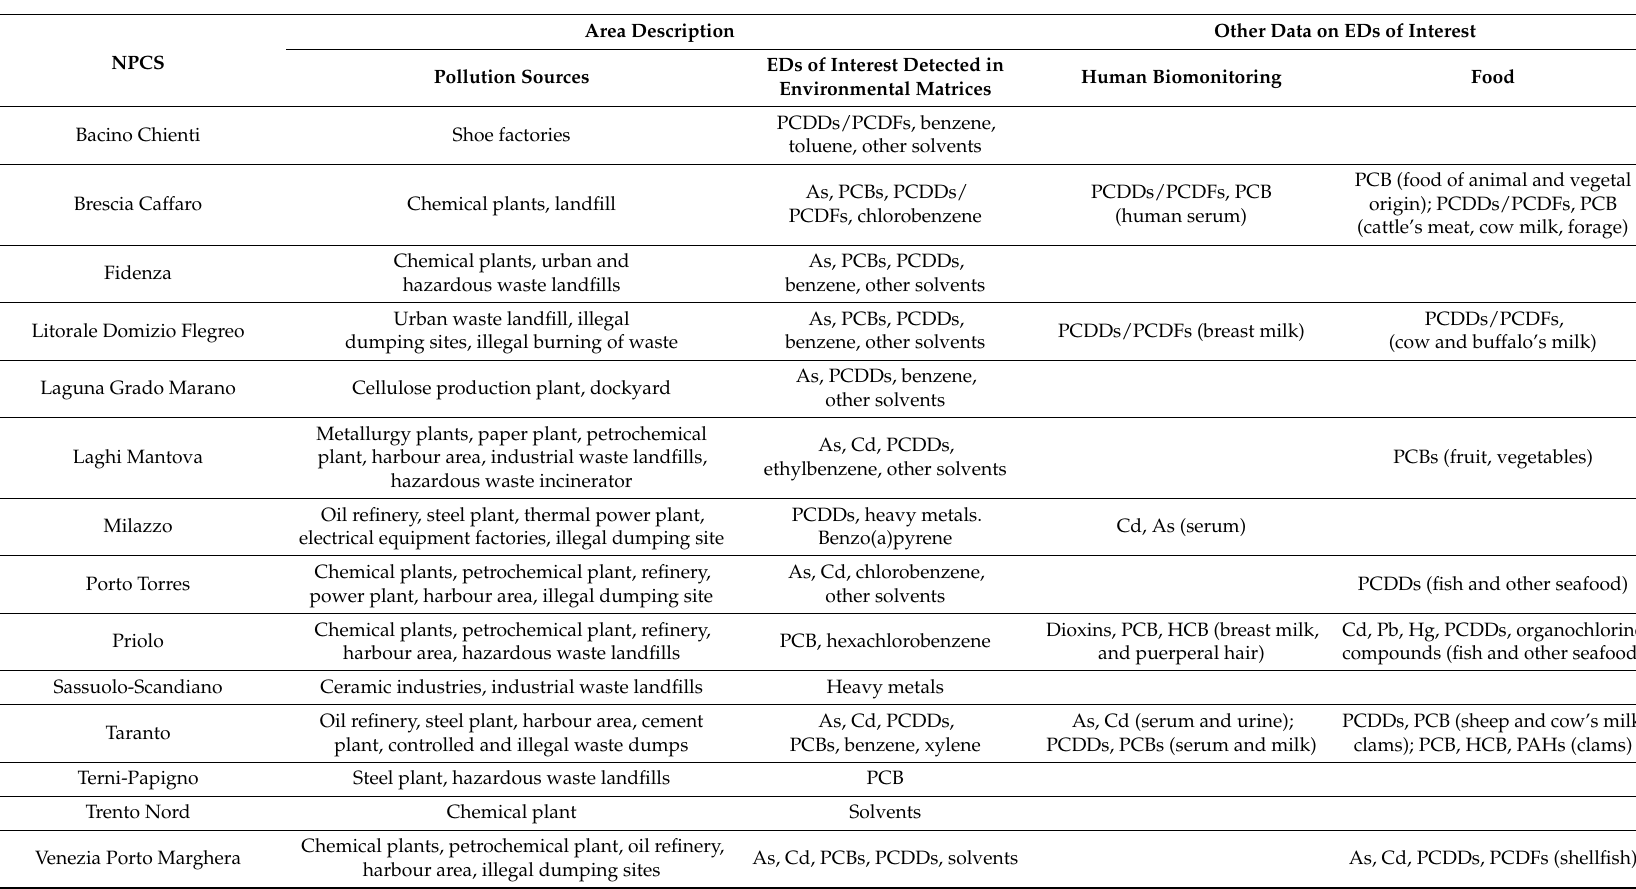
Table 2. National Priority Contaminated sites (NPCSs) information on pollution sources, and endocrine disruptors (EDs) of interest detected in environmental matrices, human biological samples, and